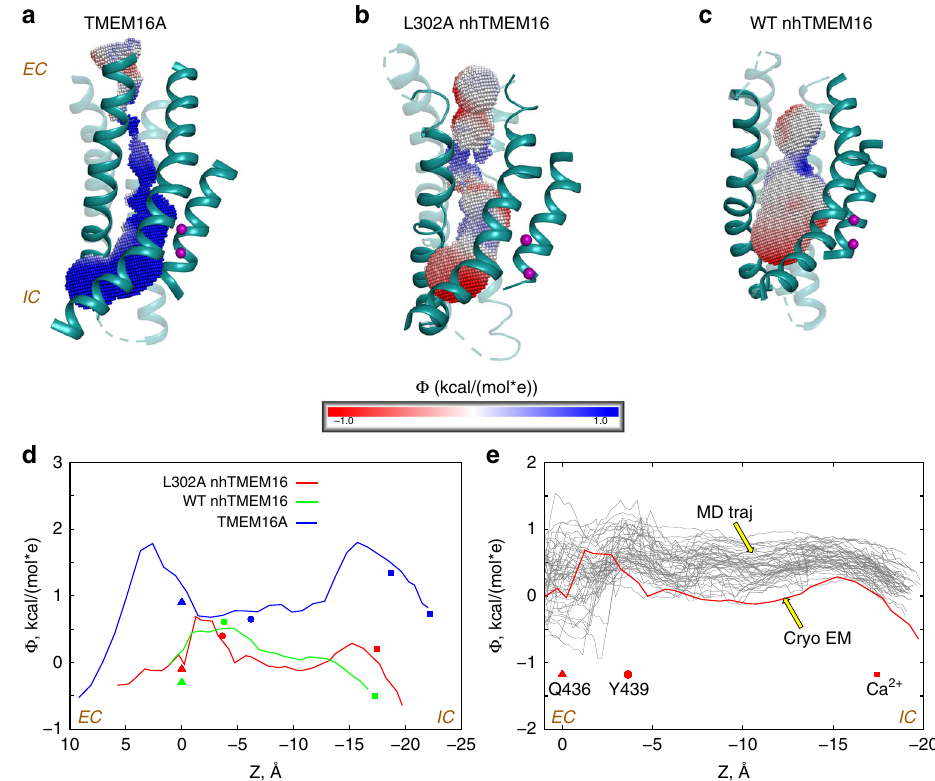
Fig. 9 Comparative analysis of the electrostatic characteristics of the groove. a – c The electrostatic potential in the pore region of various TMEM16 constructs, obtained by solving linear Poisson-Boltzmann equation (see “ Methods ” ) are depicted on the surface created by the [ − 1.0; 1.0] kcal/(mol e) range of values in the groove. The results are shown for: a TMEM16A (PDBID 5OYB); b the cryo-EM structure of L302A-nhTMEM16; and c wild-type nhTMEM16 (PDBID 4WIS). The electrostatic potential in the range of [ − 1.0; 1.0] kcal/(mol e)) is overlaid on the groove helices (TMs 3, 4, 6, and 7) of the respective structures. The Ca 2 + ions are shown as purple spheres. The locations of the EC and IC vestibules are marked. d The electrostatic potential along the pore axis from the calculations shown in ( a ). The decreasing Z coordinate along the pore axis corresponds to EC → IC direction. The locations of selected relevant residues are marked with different symbols, with the colors specifying the TMEM16 construct as follows: Red = L302A-nhTMEM16; Blue = TMEM16A; and Green = wild-type nhTMEM16. With the respective colors, the symbols represent the following: Triangle = C α atom of Q436 (Q637 in TMEM16A); Dot = C α atom of Y439 (I641 in TMEM16A); and Square = Ca 2 + . e The electrostatic pro fi le along the pore axis in the cryo-EM structure of L302A-nhTMEM16 (red thick line), and in 50 evenly spaced frames from the last 500 ns of the 2 μ s MD simulation of the L302A (gray lines, see also Fig. 8). As in ( b ), the decreasing Z coordinate along the pore axis corresponds to EC → IC direction. The locations of selected relevant residues are marked with symbols following the same code as in ( b wild-type nhTMEM16 scramblase (PDBID 4WIS), and (ii)-the Ca 2 + -bound TMEM16A channel (PDBID 5OYB). The electro- static potential (EP) pro fi les along the groove region of each construct was calculated by solving the corresponding linear